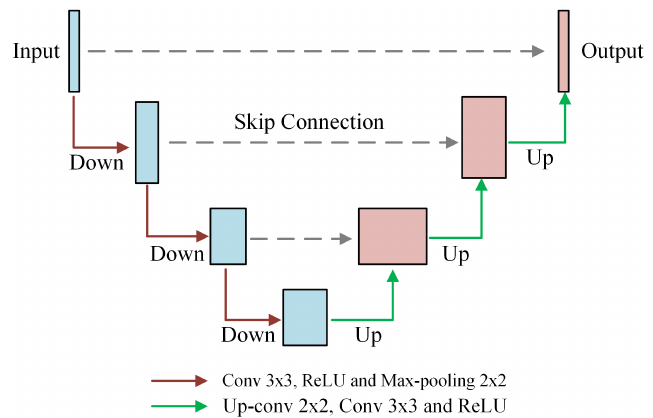
Figure 3. The U-Net architecture of our denoising